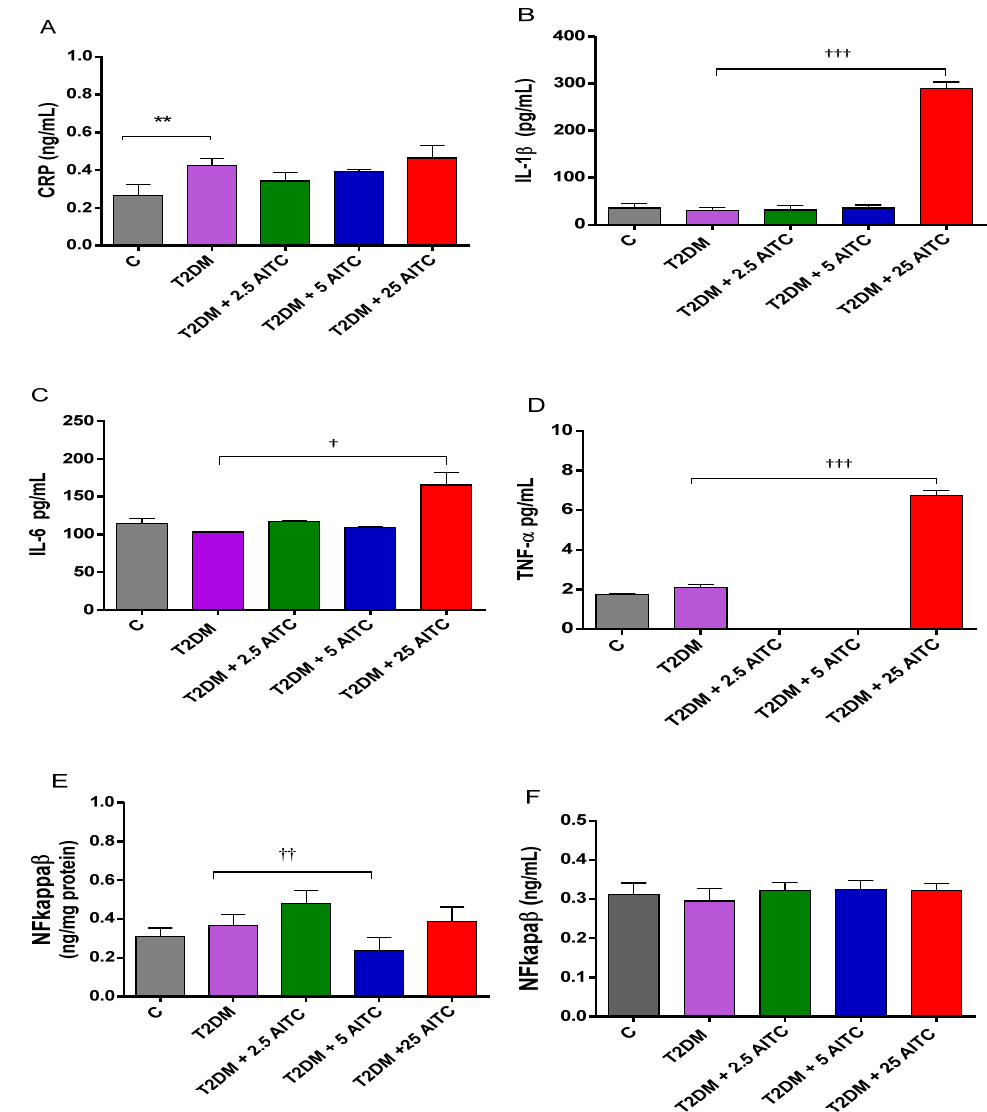
Figure 2. Effects of AITC on inflammatory markers: CRP ( A ), IL-1 β ( B ), IL-6 ( C ), TNF α ( D ) concentrations in the blood serum and NF- κ B transcription factor contents in the liver ( E ) and the blood serum ( F ) of diabetic rats. Each column represents the mean ± SEM ( n = 8). ** p ≤ 0.01 compared with C group; † p ≤ 0.05, †† p ≤ 0.01, ††† p ≤ 0.001 compared with T2DM group. Abbreviations: C—control group; T2DM—high-fat diet with STZ-injected group; T2DM +AITC 2.5; AITC 5; AITC 25—high-fat diet with STZ-injected group with oral administration of 2.5; 5; 25 mg/kg b.w. AITC,